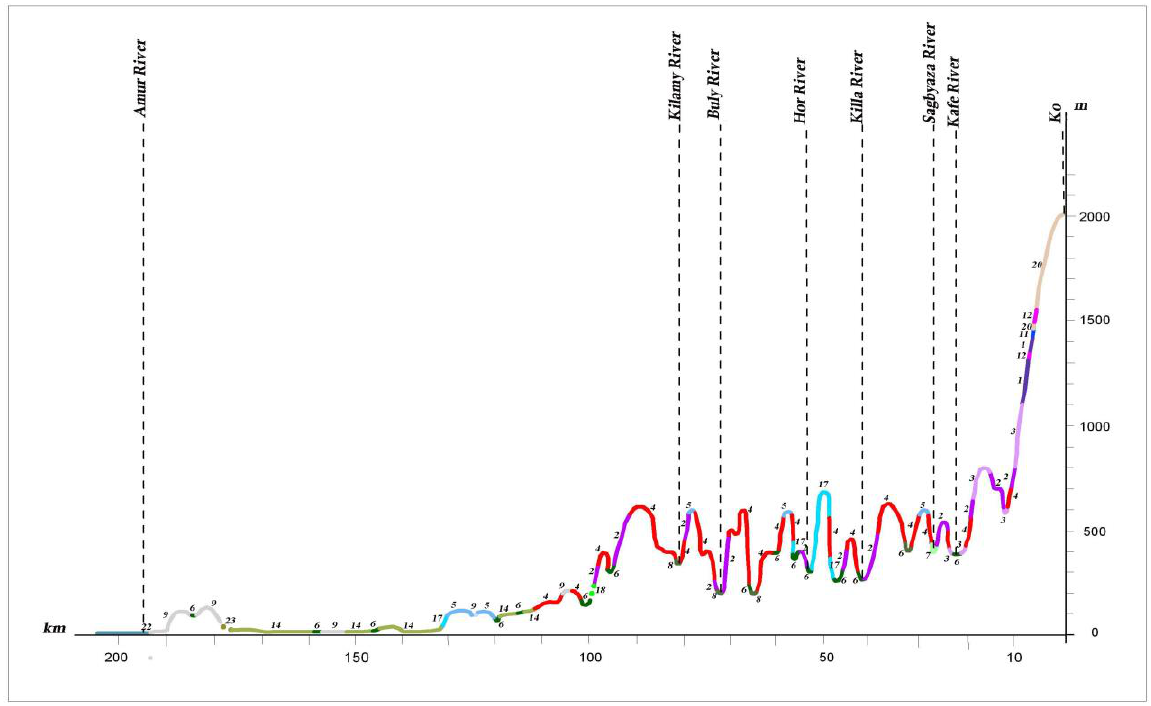
Figure 11. Profile of the plant cover from the mountain Ko to the Amur River (I A) (see the legend in the Figure 10).